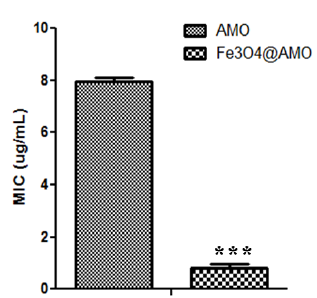
Figure 9. MIC values obtained for the nanoparticles functionalized with antibiotics against E. coli ATCC 25922, as compared with control MIC values, represented by plain antibiotic solutions. *** p < 0.01.